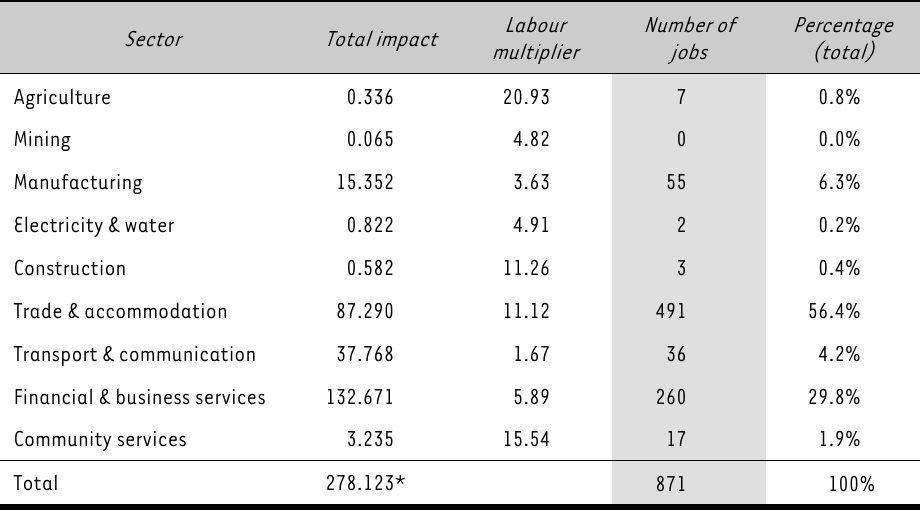
Total impact of spending on employment